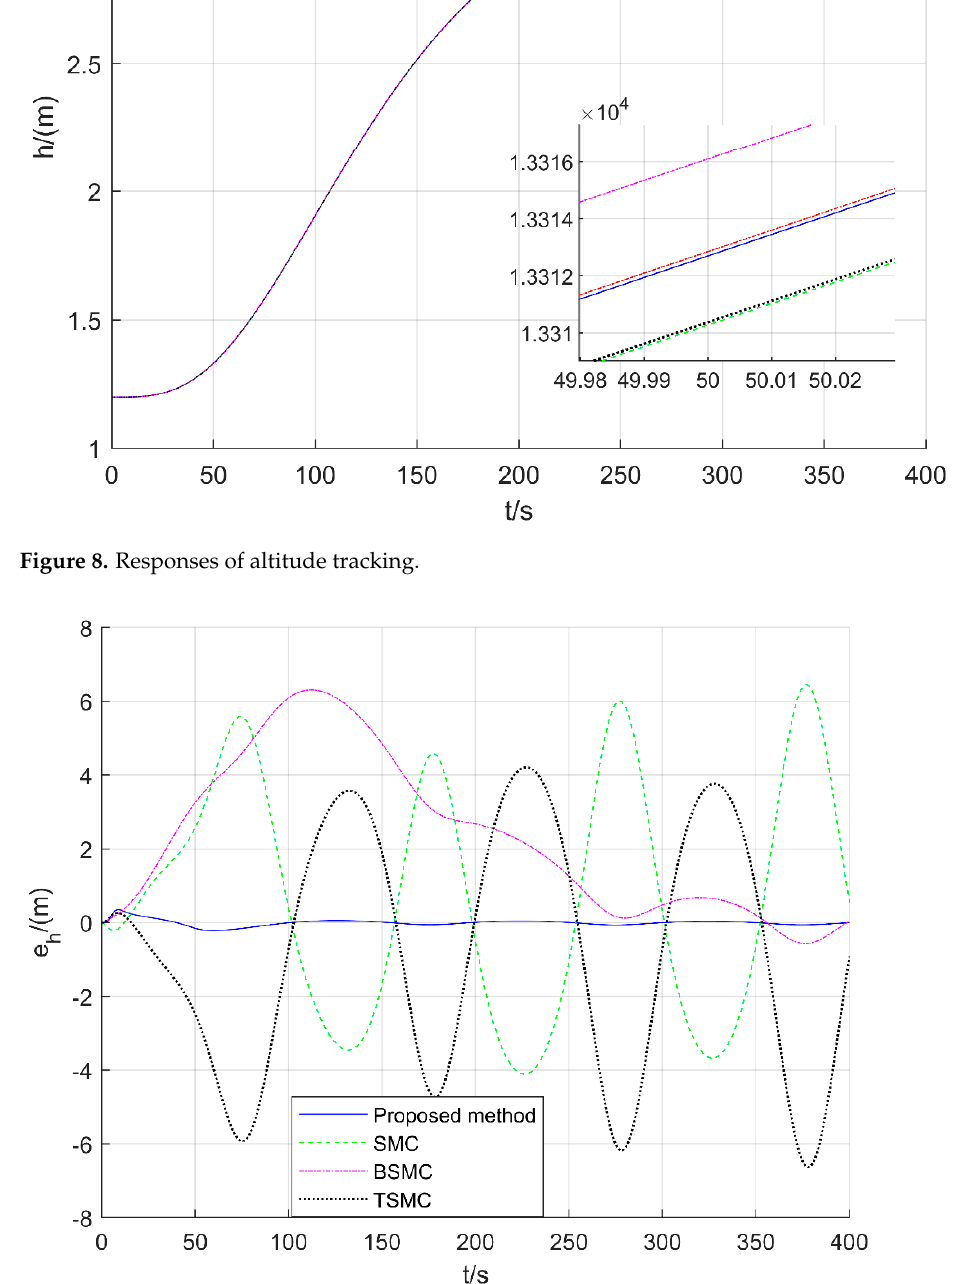
Figure 9. Tracking errors of altitude.